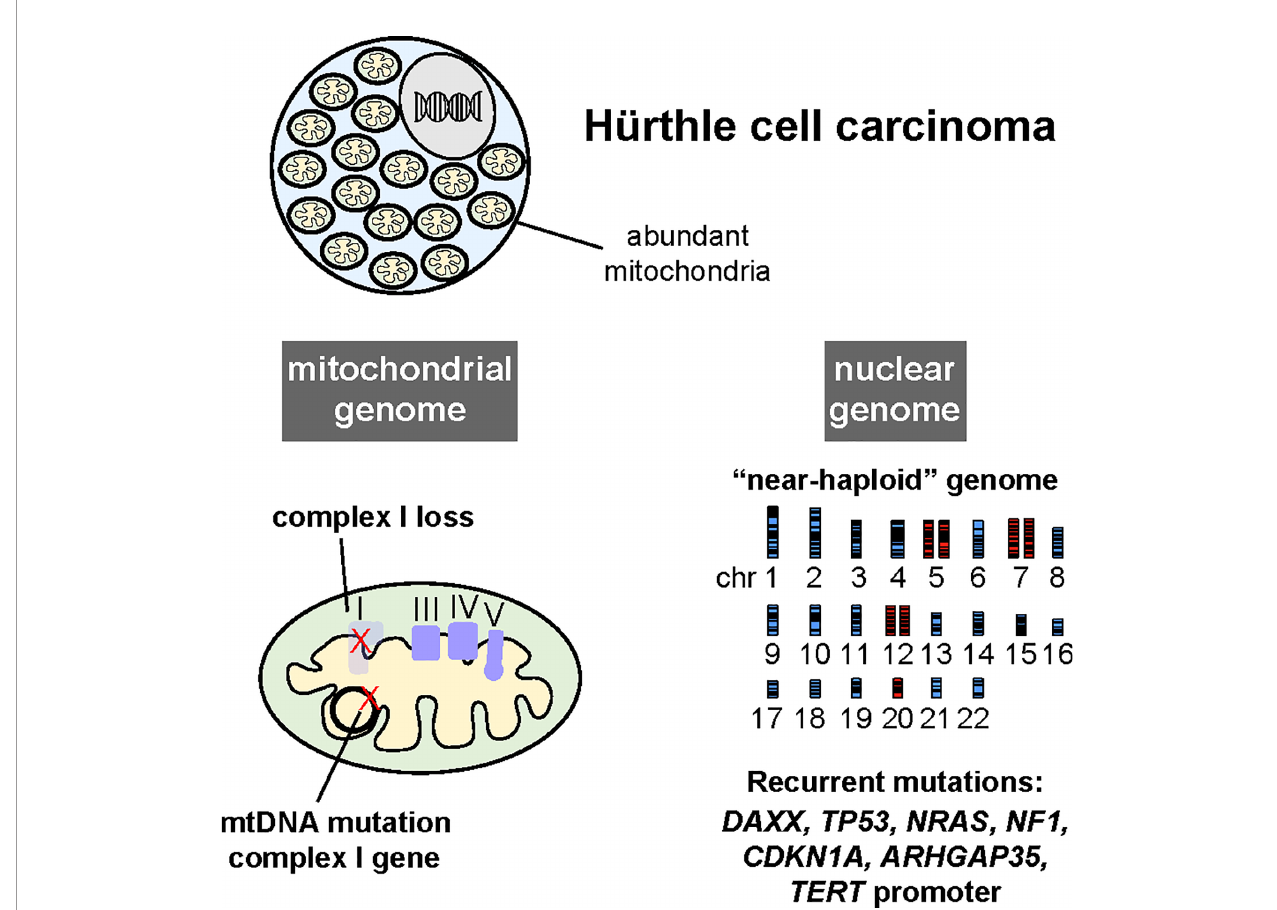
FIGURE 4 | Hürthle cell carcinomas harbor recurrent mutations in genes encoding complex I of the electron transport chain in the mitochondrial genome (mtDNA), widespread loss of chromosomes leading to a near-haploid state, and recurrent mutations in several oncogenes and tumor suppressor genes, albeit at a low frequency. (Reproduced with permission from Gopal, RK, Kübler K, Calvo SE et al. Widespread chromosomal losses and mitochondrial DNA alterations as genetic drivers in Hürthle cell carcinoma. Cancer Cell 2018;